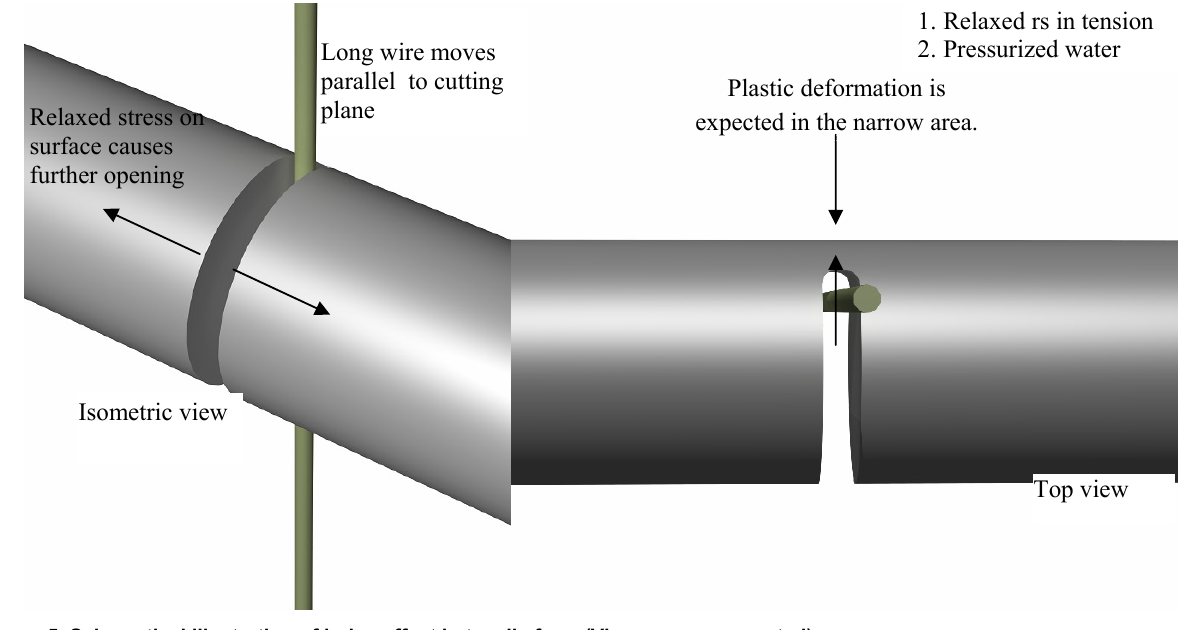
Figure 5. Schematical illustration of bulge effect in tensile form (Views are exaggerated)